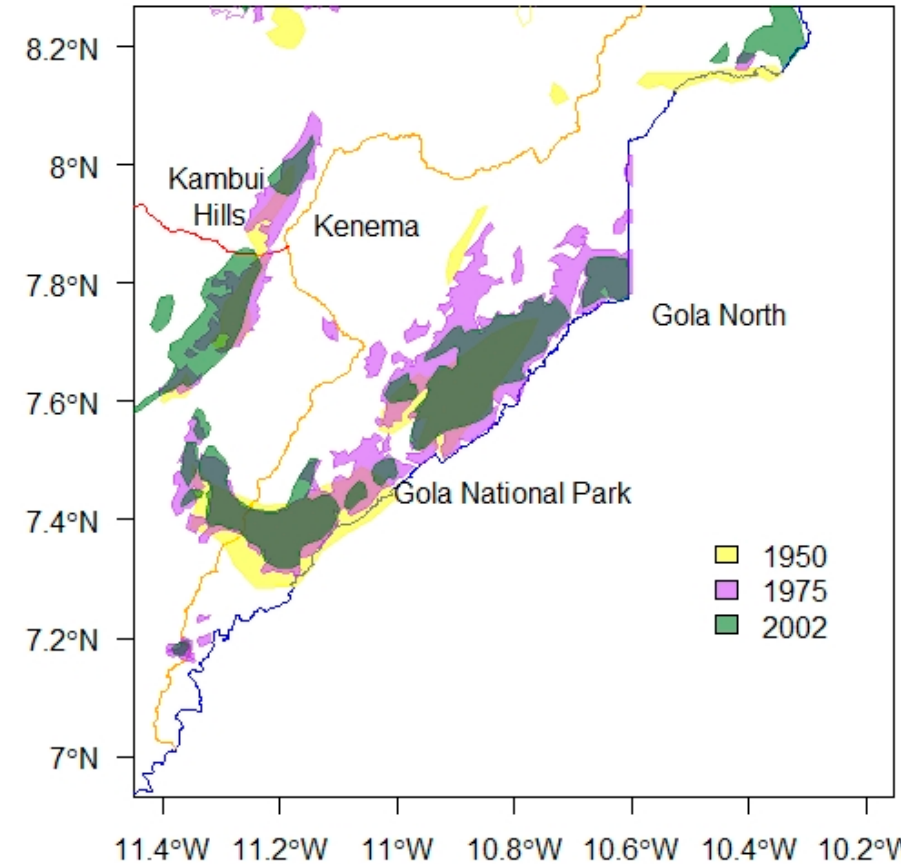
Figure 5. Forests of the South-East; Gola and the Kambui Hills.